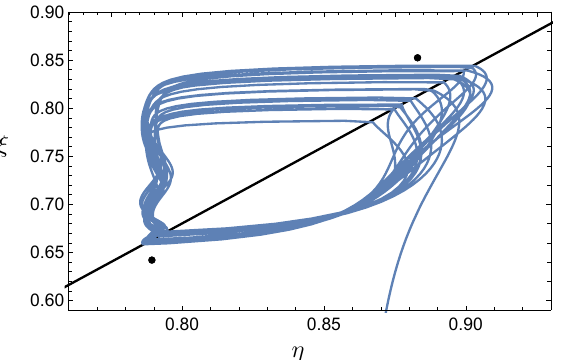
Figure 11. A typical trajectory with eccentricity and obliquity forcing, computed from 2 million years ago to the present. The model continues to exhibit glacial cycle behavior. D G = 0.3, D I =